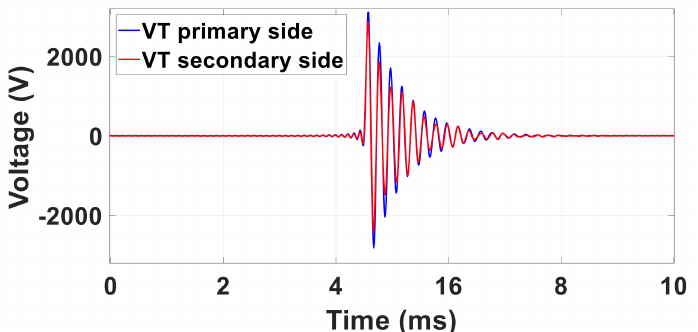
Figure 7. Oscillatory transient characterized by U OT = 22% of U n , f OT = 5 kHz and τ = 600 µ s, ϕ OT = 0 rad measured at VT primary side (blue curve) and secondary side (red curve).